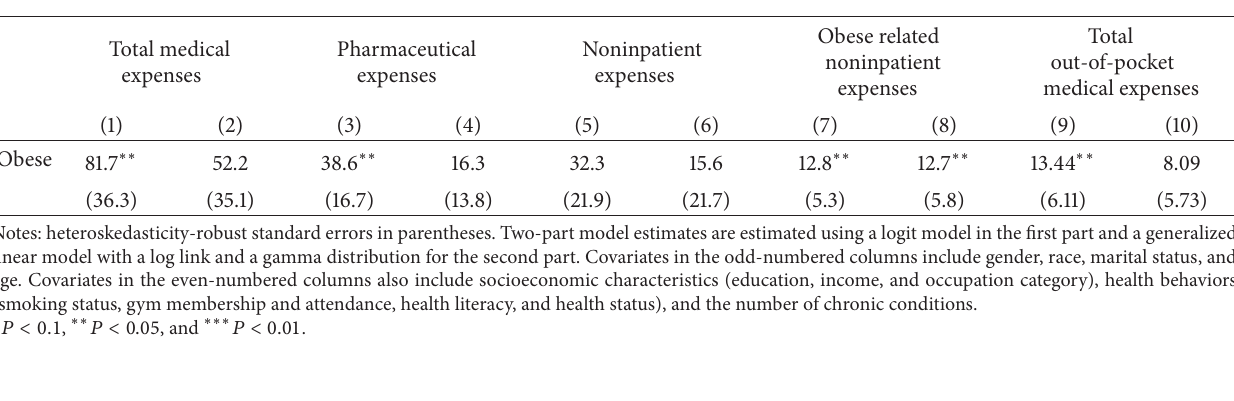
Table 3: The relationship between obesity and average monthly medical expenses (two-part model estimates) ( 𝑁 = 454